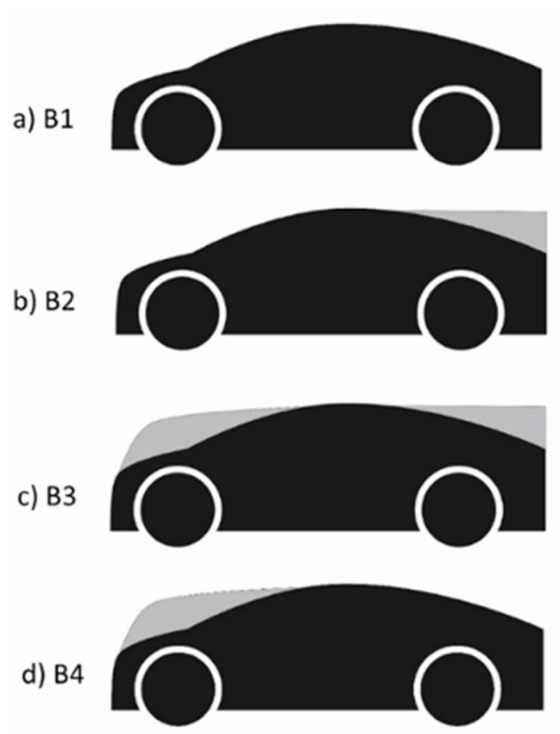
Figure 3. Upper body style configurations of Resnick models: ( a ) B1 Baseline, ( b ) B2 Baseline with Backlight add-on, ( c ) B3 Baseline with Nose and Backlight add-ons, ( d ) B4 Baseline with Nose add-on, after [50] © SAE International